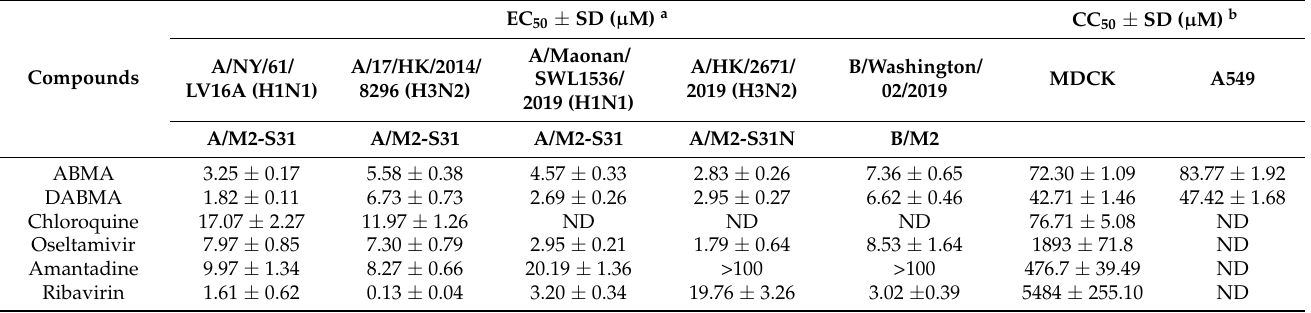
Figure 1. Cytotoxicity of ABMA and DABMA and their antiviral activities against influenza virus in vitro. ( A , B ) Chemical structures of ABMA and DABMA. ( C , D ) MDCK cells were treated with increasing concentrations of ABMA or DABMA. Cell viability was measured and compared to the untreated cell control after incubation for 72 h. ( E , F ) MDCK cells were treated with increasing concentrations of ABMA or DABMA for 5 h before infection with influenza virus (MOI = 0.01). Cytopathic effect was measured and compared to the untreated cell control at 48 hpi. ( G , H ) MDCK cells or ( I , J ) A549 cells were treated with increasing concentrations of ABMA or DABMA for 5 h before infection with influenza virus (MOI = 0.01). The viral titer (TCID 50 /mL) in supernatants was analyzed at 48 hpi. Data represent mean ± SEM, n = 3. The experiments were repeated twice independently. Statistical significance was determined with one way ANOVA. Significance: ** p < 0.01, *** p < 0.001 compared with virus control group. Table 1. Cytotoxicity and antiviral activity of compounds against influenza virus infection.